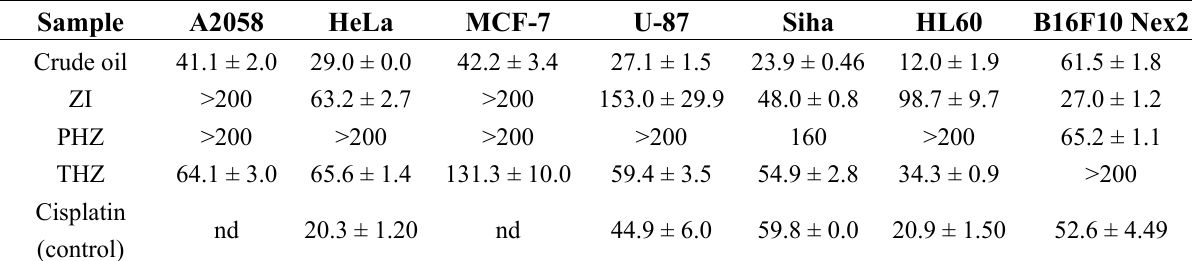
(µg/mL) values to essential oil from leaves of C. sylvestris , zingiberene and Table 2. IC 50 derivatives (partially hydrogenated zingiberene-PHZ and totally hydrogenated zingiberene- THZ) as well as positive control (cisplatin) against cell